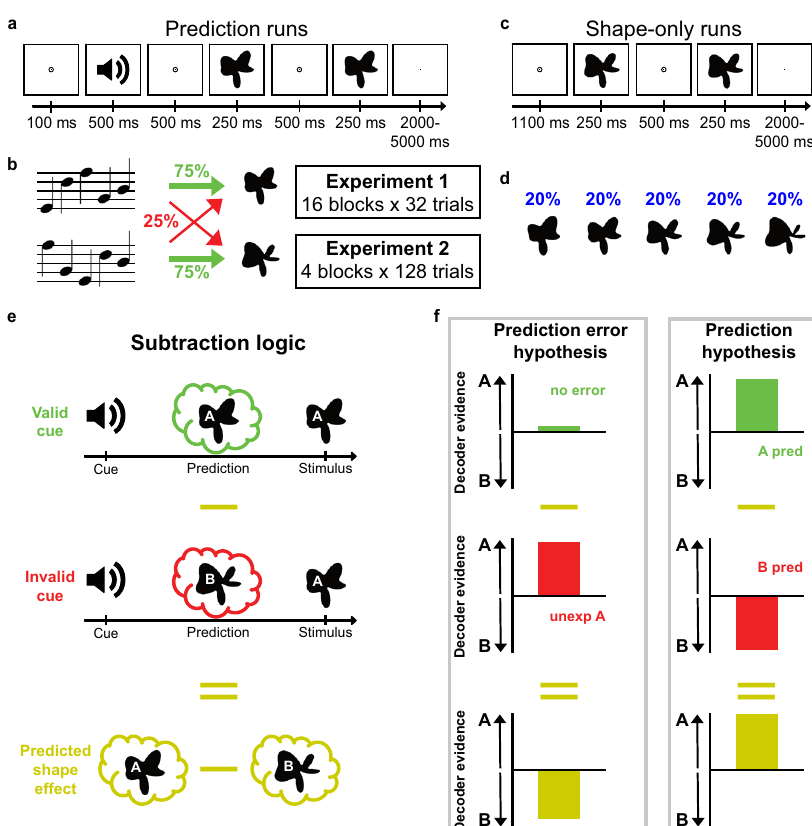
Fig. 1 Experimental paradigm and analysis. a During prediction runs, an auditory cue preceded the presentation of two consecutive shape stimuli. On each trial, the second shape was either identical to the fi rst or slightly warped with respect to the fi rst along an orthogonal dimension, and participants ’ task was to report whether the two shapes were the same or different. b The auditory cues predicted whether the fi rst shape on a given trial would be shape 2 or shape 4 (of 5 shapes). The cue was valid on 75% of trials, whereas in the other 25% of (invalid) trials the unpredicted shape was presented. c During shape-only runs, no auditory cues were presented. As in the prediction runs, two shapes were presented on each trial, and participants ’ task was to report the same or different. d All fi ve shapes appeared with equal (20%) likelihood during shape-only runs. e Subtracting the response evoked by invalidly from validly predicted shapes isolated the effect of the predictive cues. f Hypothesised shape decoding results if the hippocampus represents either prediction errors (left column) or predictions (right